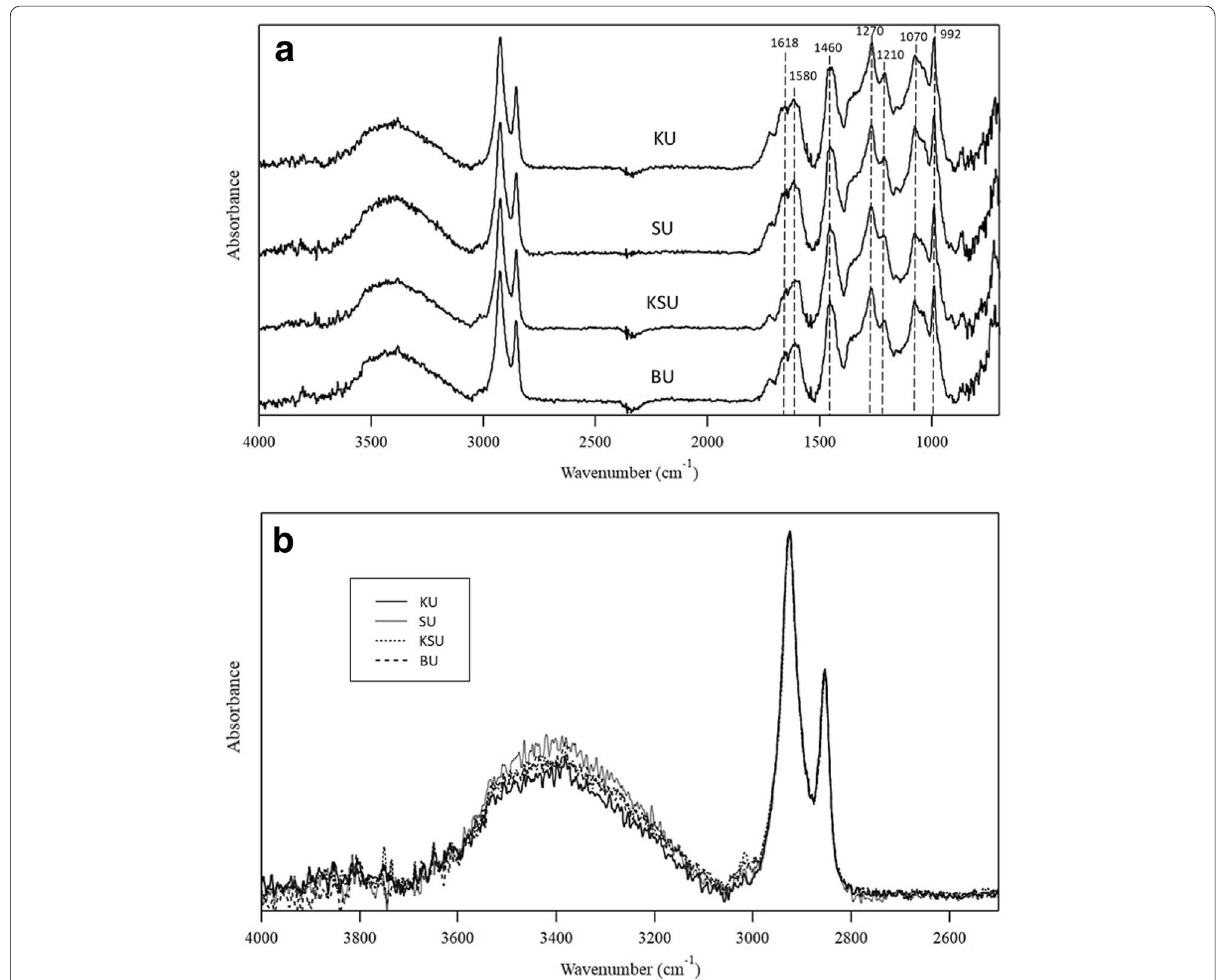
Fig. 5 FTIR spectra of the each urushi film in the range of 4000–650 cm − 1 ( a ) and magnified figure of broad band between 3600 and 3200 cm − 1 ( b )